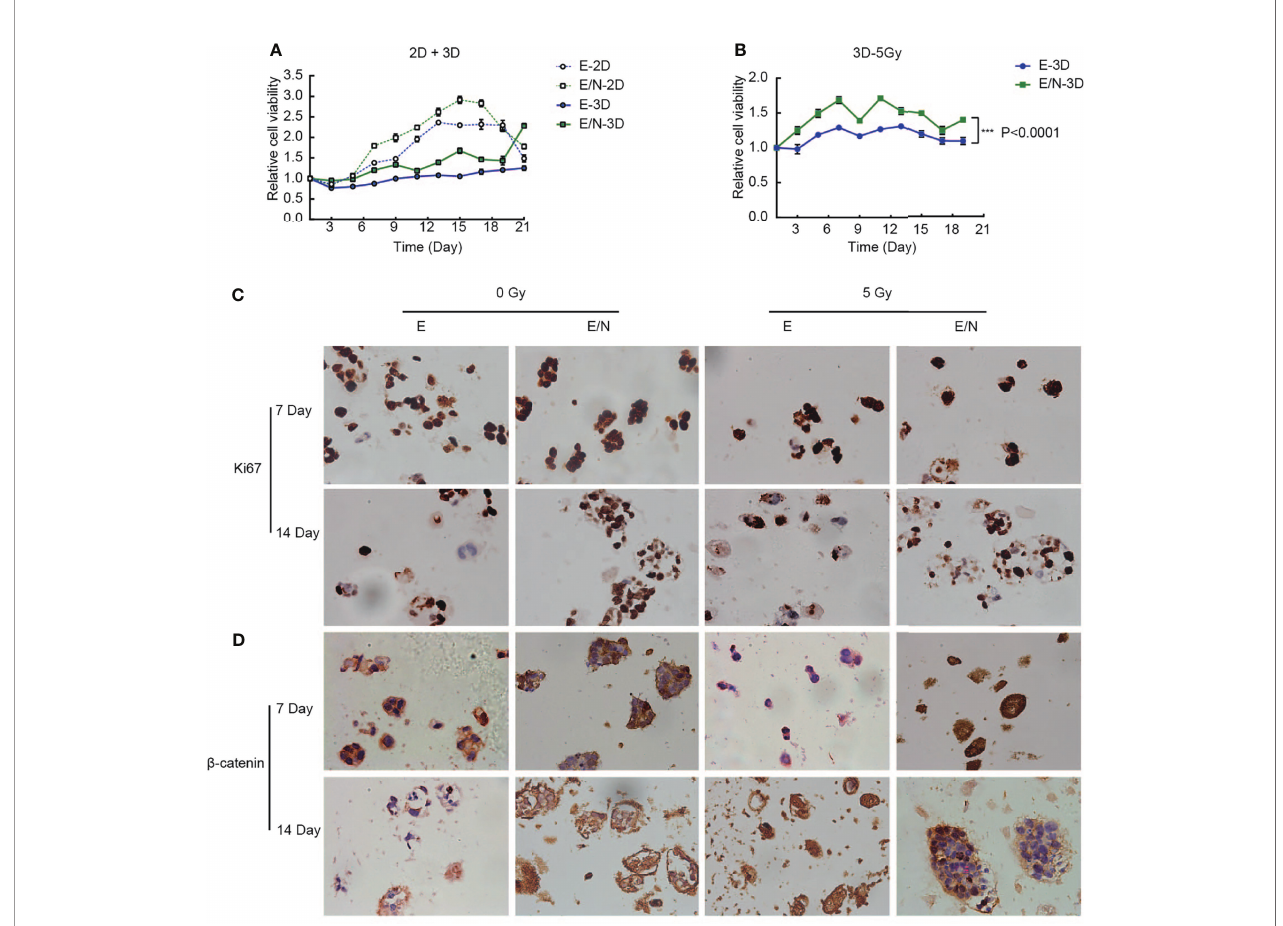
FIGURE 5 | Overexpression of NRAGE enhanced the proliferation and radioresistance of ESCC cells in 3D bioprinted hydrogels. (A) Comparing cell proliferation between E and E/N in 2D and 3D by alamarBlue assays; (B) Cell proliferation was tested by immunohistochemistry of 3D bioprinted E and E/N cells: Ki-67 expression at 7,14 d in culture with or without IR; (C) cell viability between E and E/N in 3D after 5 Gy IR by alamarBlue assays; (D) Immunohistochemistry of 3D bioprinted E and E/N cells: b -catenin expression at 7, 14, and 21 d in culture with or without IR. Scale bars: (B, D) 50 m m, all data represented as means ± SD. *** p < 0.001 vs.